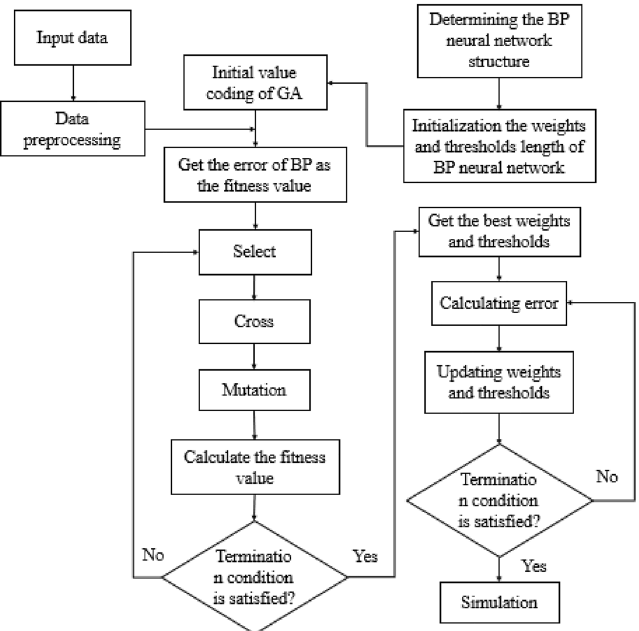
Figure 3. Genetic algorithm optimizes the BP neural network